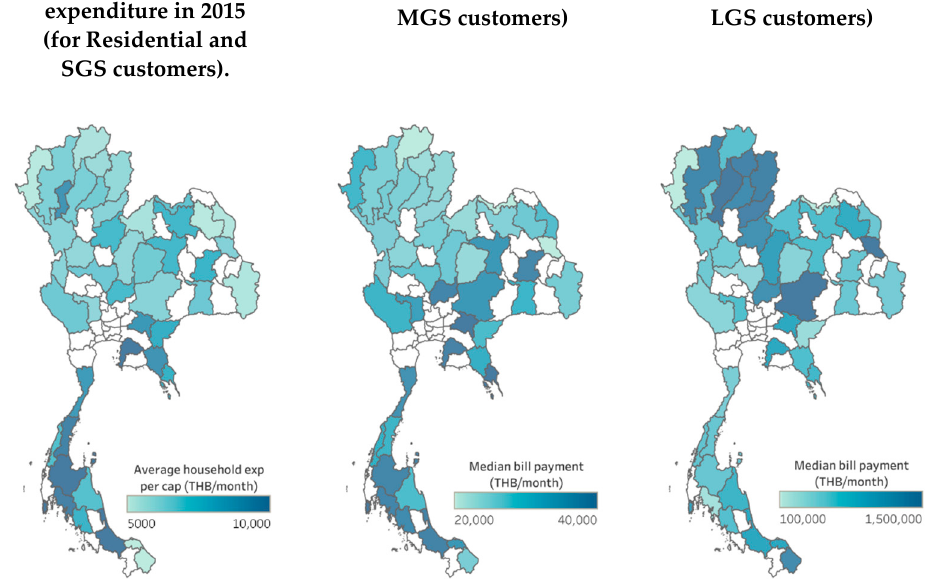
Figure 5. Socioeconomic measures by province.